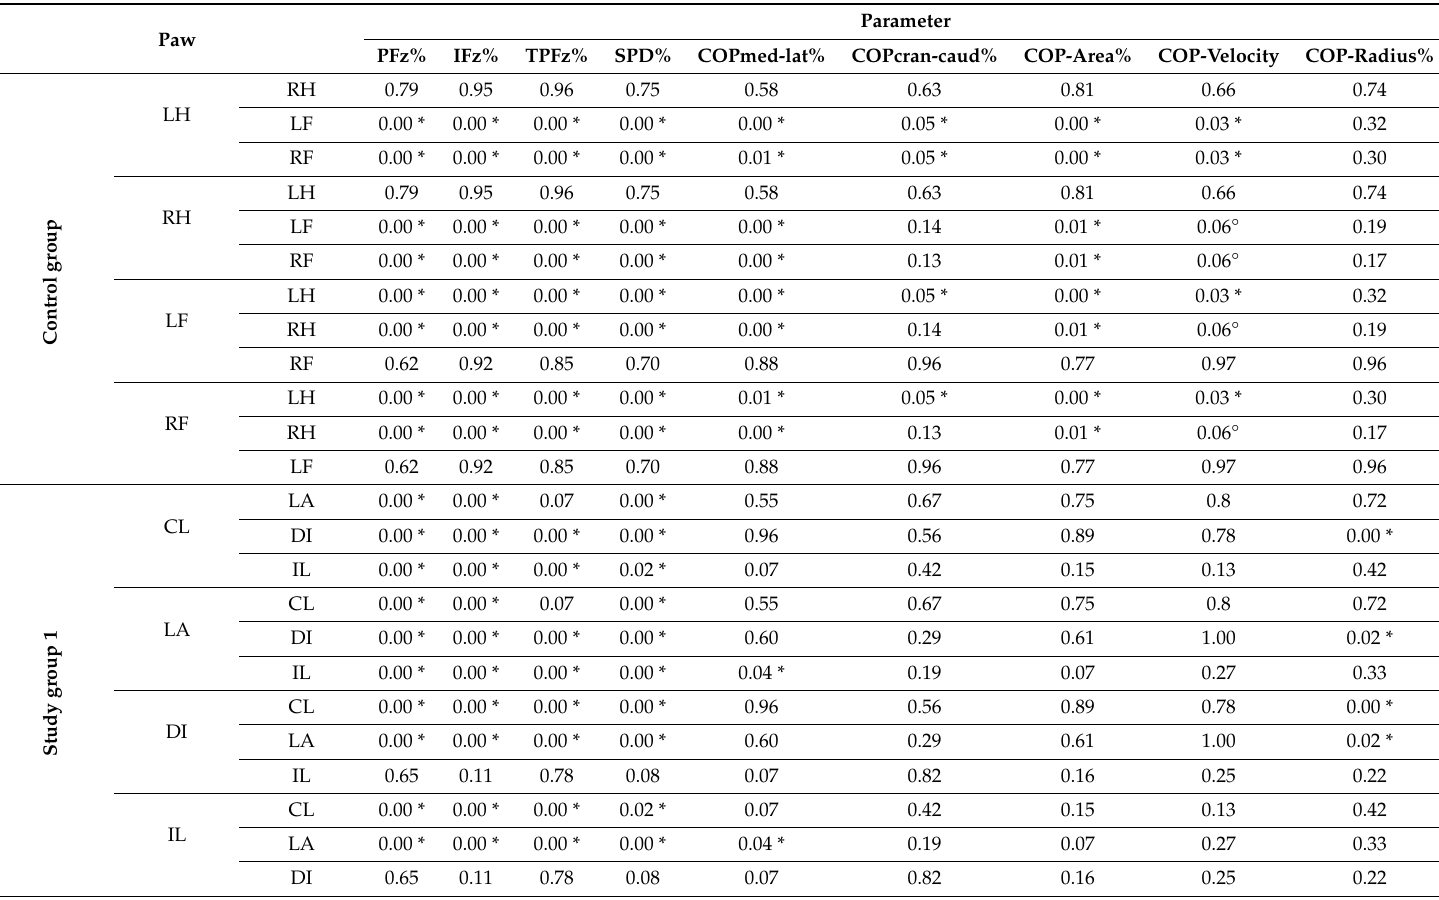
Table A1. p -values within the study groups and the control